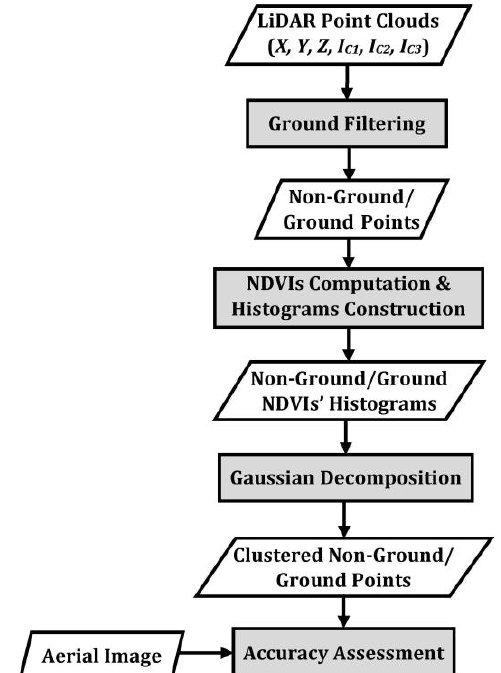
Figure 3. The clustering method